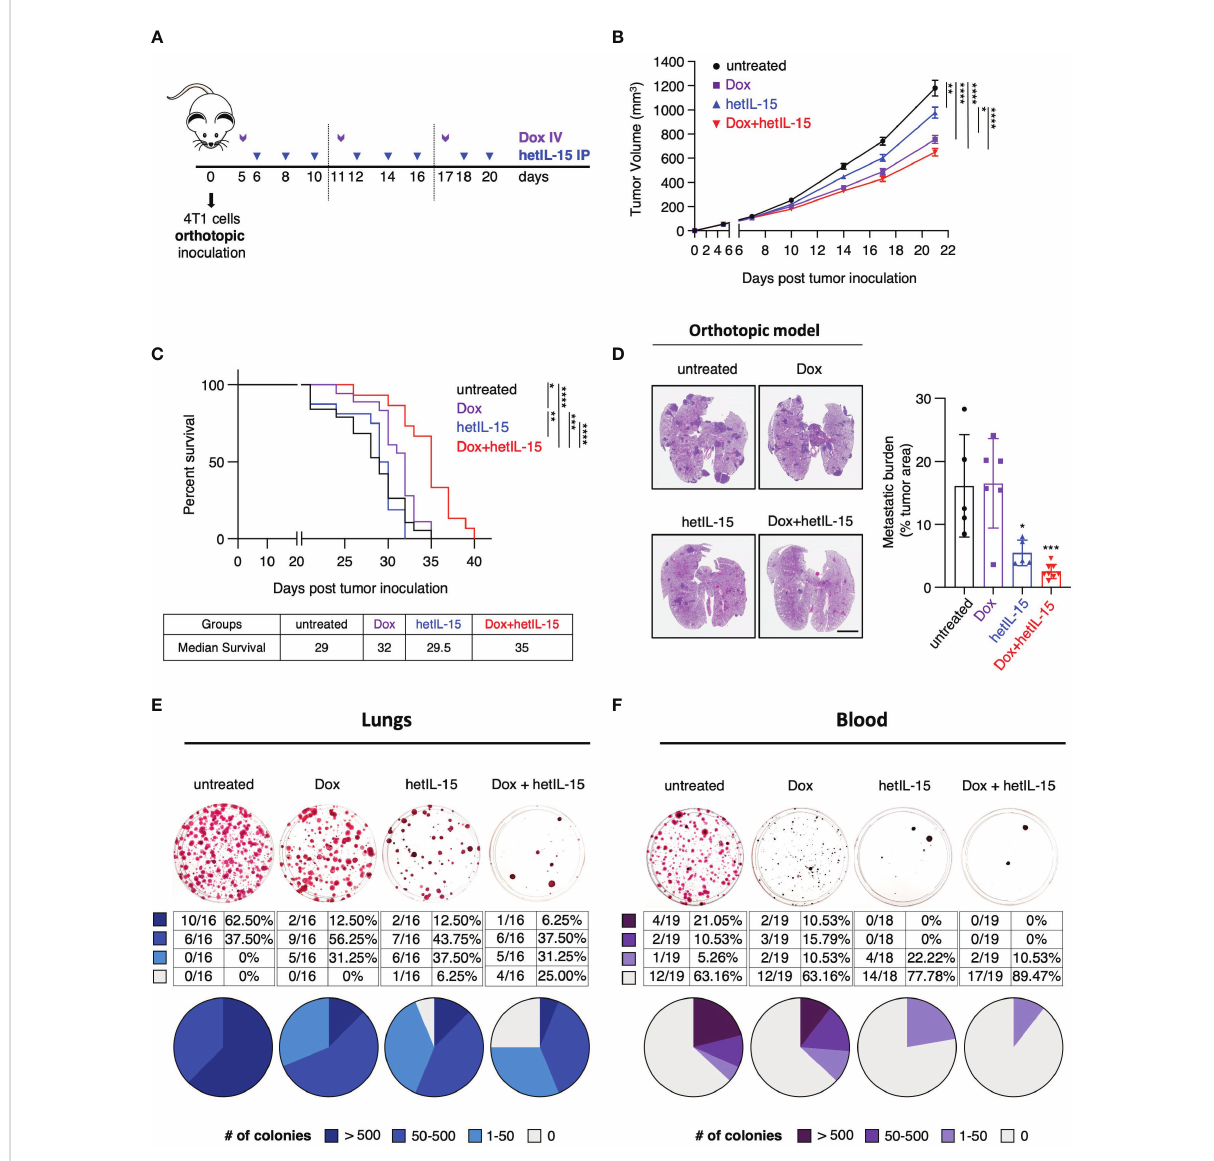
FIGURE 1 hetIL-15 improves doxorubicin ef fi cacy in extending survival by inhibiting metastatic formation in the lungs and CTCs dissemination in the blood. (A) Cartoon showing the treatment design. 0.35-1x10 6 4T1 cells were orthotopically inoculated in Balb/c mice and the animals were randomized in four groups: (i) untreated (PBS), (ii) Dox (Doxorubicin)-treated, (iii) hetIL-15-treated and (iv) Dox+hetIL-15-treated. Treatment started on day 5 post tumor inoculation with Dox (5mg/kg IV, purple arrows) once per week, followed by hetIL-15 (3 m g/mouse IP, blue arrows) every other day until day 20. (B) Tumor growth curves for each group overtime until day 21. Data were merged from 6 independent studies (n=54-60). Tumor volume (mm 3 ) ± SEM for each time point is shown. Statistical analysis was done by mixed effects analysis model and Tukey ’ s multiple comparisons test. (C) Percent survival of the mice in each group. Statistical analysis was performed by Log-rank (Mantel-Cox) test and data merged from two independent experiments (n=15-19). (D) Representative images from H&E-stained lung sections (left panel), and the percentage of tumor areas present in each mouse lungs (right panel, asterisks show the signi fi cance of difference from the untreated group) presented as mean ± SD for each group. Data derived from one survival study (n=5-8) of (C) . Scale bar, 4mm. Statistical analysis was done by one-way ANOVA and Tukey ’ s multiple comparisons test. (E, F) Representative images (upper panels) from clonogenic assays showing SRB- stained tumor colonies derived from lungs (E) and blood (F) , and tables with the number and the percentage (plotted in pies) of mice with different number of tumor colonies (lower panels) in each group on day 22. Data were merged from 3 independent experiments (n=16) for the lungs and 2 independent experiments (n=18-19) for the blood. Legend shows number of tumor colonies in 4 different ranges. * p < 0.05, ** p < 0.01, *** p < 0.001, **** p < 0.0001, SD, standard deviation; SEM, standard error of the mean. Image Credit: